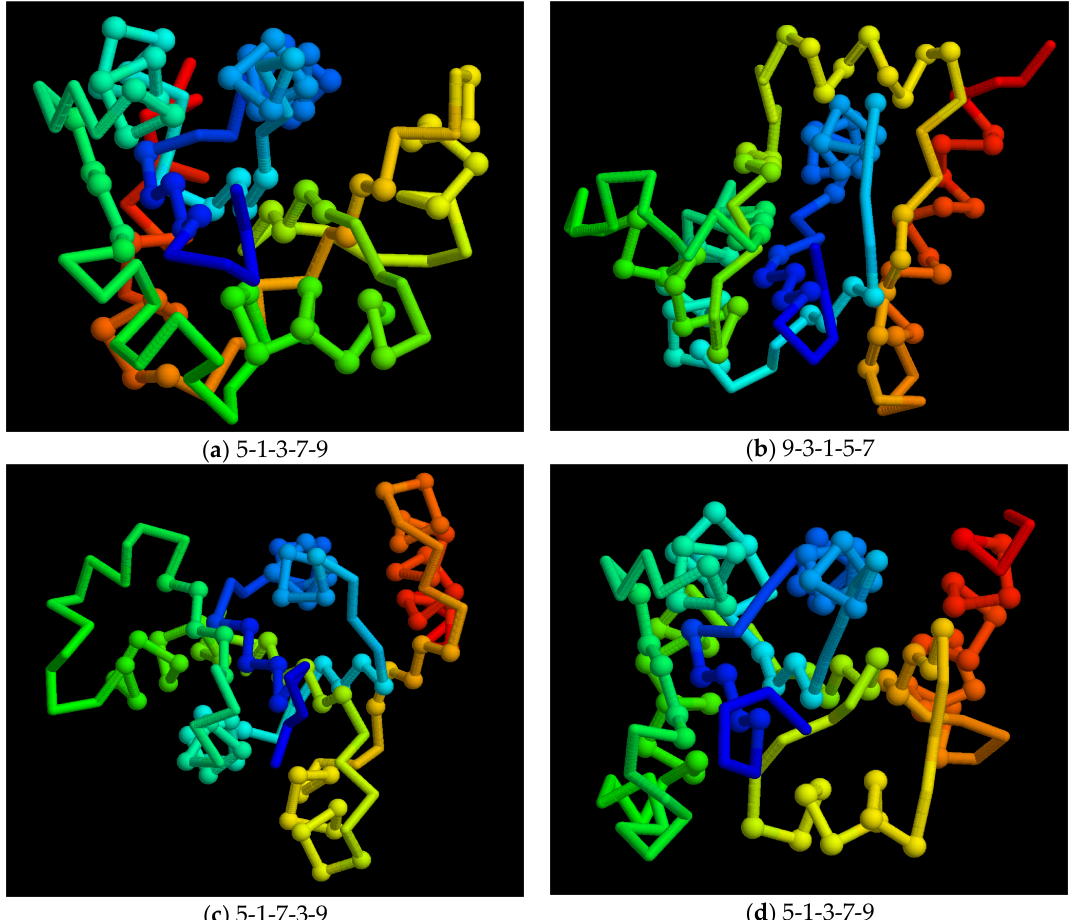
Figure 10. Model folds: A small sample of model folds is shown as a Cα backbone trace (as in Figure 9b) with the chain coloured blue to red corresponding to amino to carboxy terminus. Residues in secondary structures are marked as a small sphere. The order of the strands in the sheet is shown below each fold. Note that even though folds ( a ) and ( d ) have the same strand order, the strand direction is not recorded and these models have different folds.